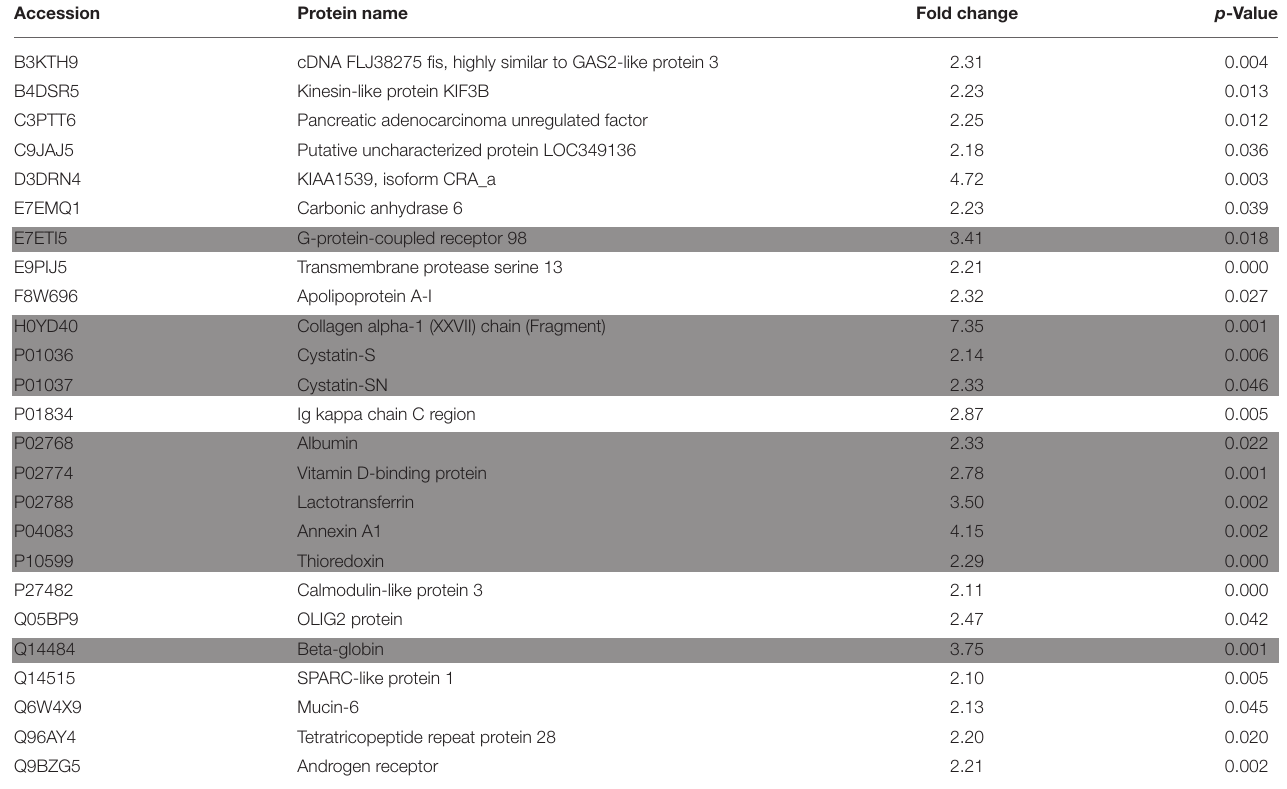
TABLE 2 | Proteins with significant increase of > 2 fold during the inflammatory phase of EG. Accession Protein name Fold change p